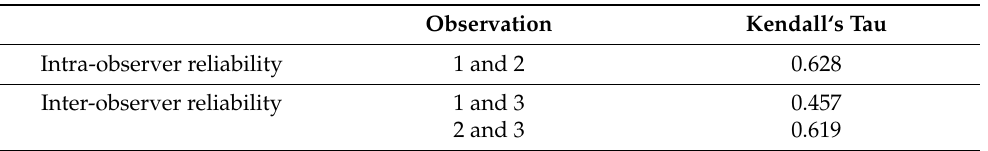
Table 4. Intra- and inter-observer reliability (Kendall’s tau) for the Pfirrmann classification of degen- erated lumbar